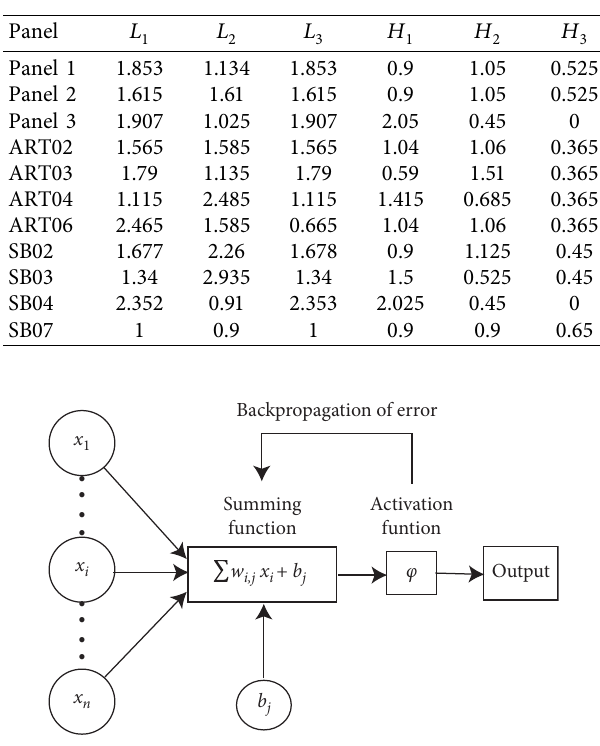
Figure 3: Simple neuron model for NN with backpropagation.